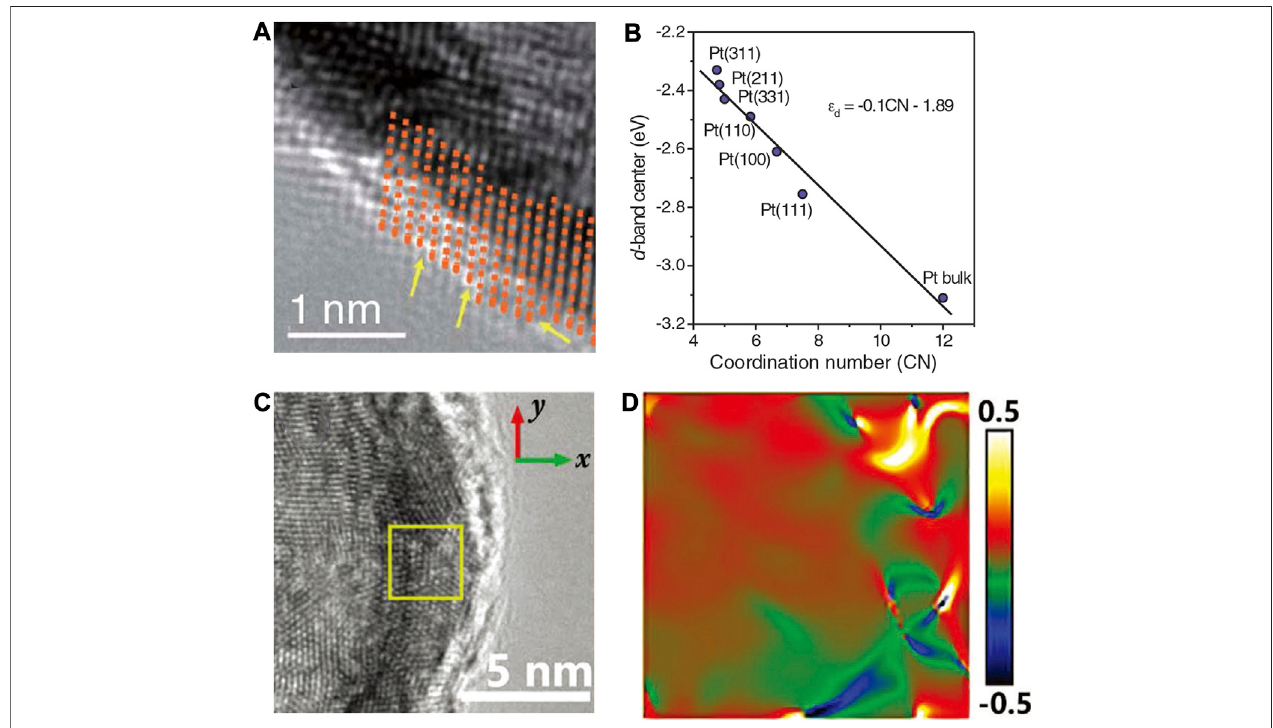
FIGURE 18 | (A) HAADF STEM image of PtNi nano-cages. Yellow arrows mark defects such as atomic vacancies. (B) The DFT-derived relationship between d-band center and generalized coordination number. (C) HRTEM image of PdAu hollow nanochains. (D) The corresponding strain distribution map by GPA algorithm. (A,B) Reproduced with permission (Tian et al., 2019). Copyright 2019, American Association for the Advancement of Science. (C,D) Reproduced with permission (Jiao et al., 2020). Copyright 2020, Wiley-VCH.